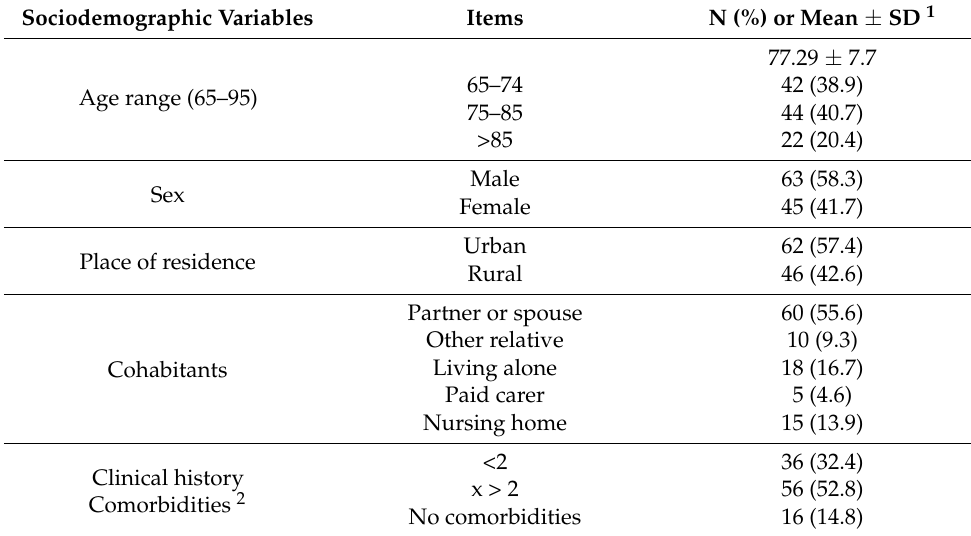
Table 1. Sociodemographic